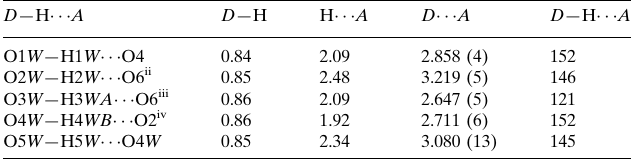
Hydrogen-bond geometry (A˚ , (cid:4)